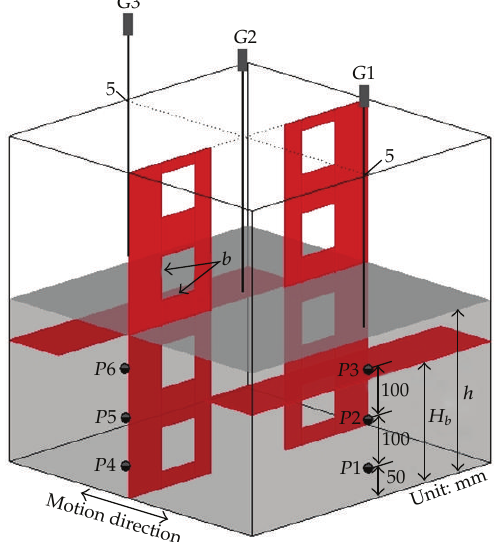
Figure 7: Schematic of liquid sloshing in cubic tank with horizontal ba ffl es and orifice vertical ba ffl es.